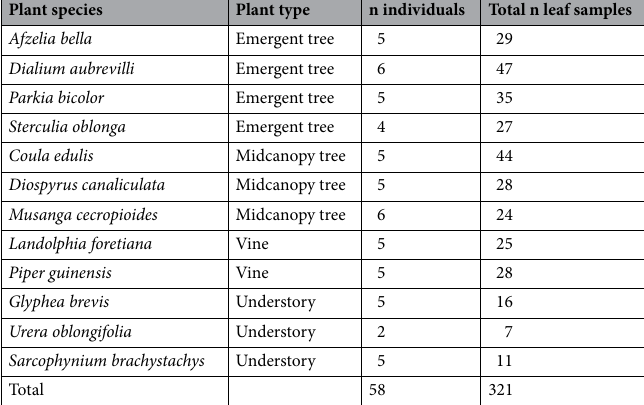
Table 1. Overview of leaf samples analyzed in this study.